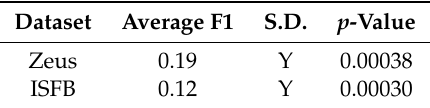
Table 16. Zeus and ISFB Similarity Using Previous Research.